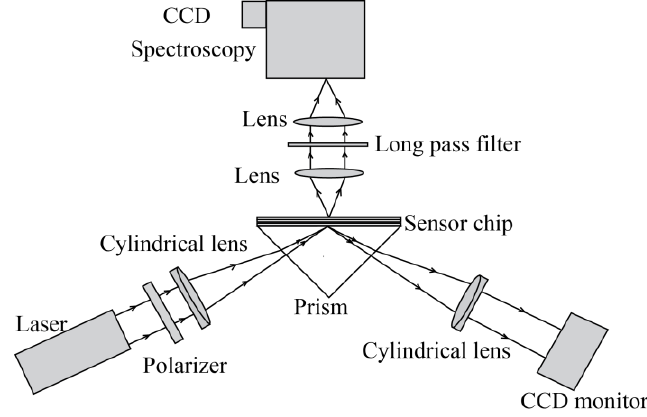
Figure 2. Schematic of the hyperspectral fluorescence detections based on a symmetrical CPWR